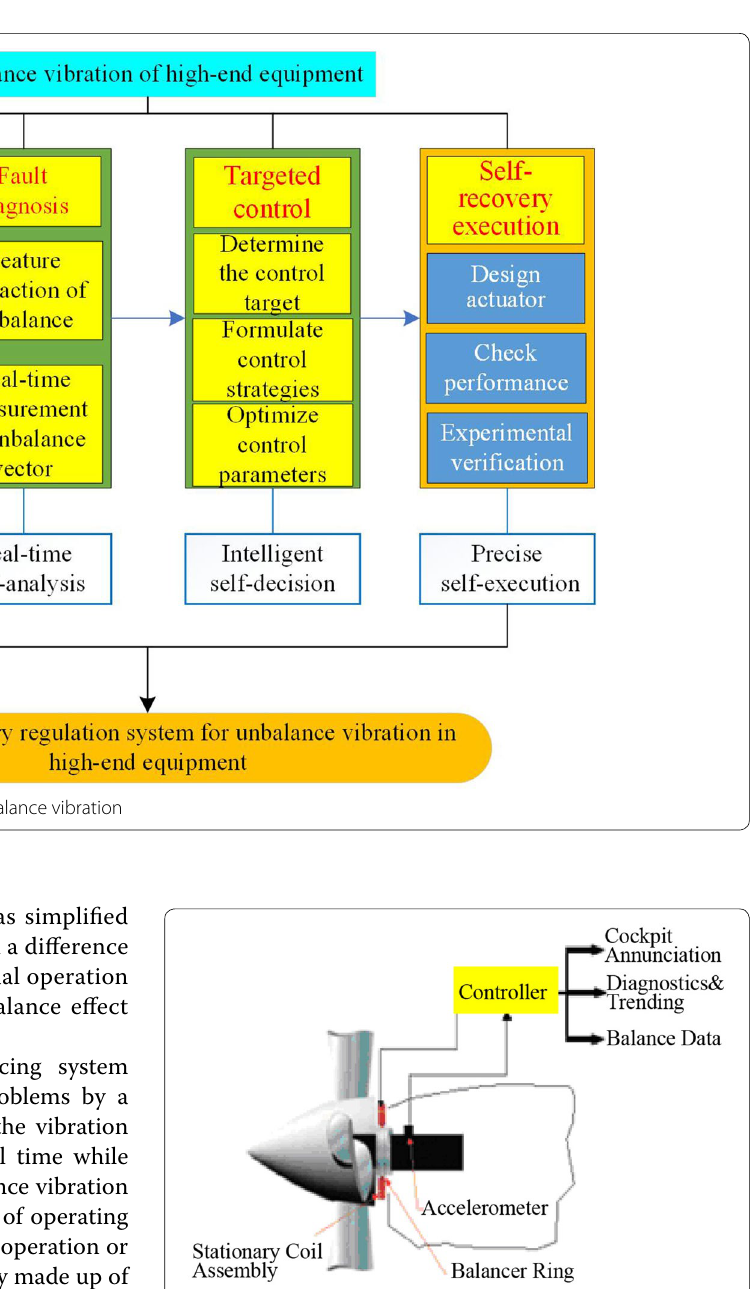
Figure 3 Schematic diagram of IPBS